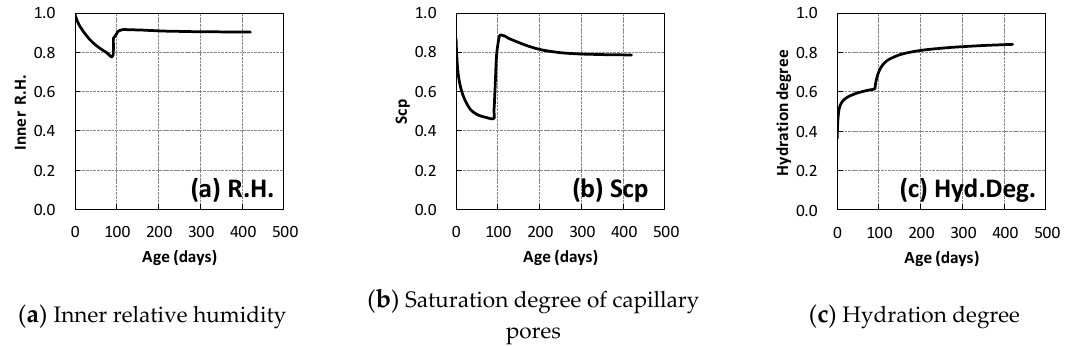
Figure 4. Numerical histories along the specific environmental condition as shown in Figure 2.